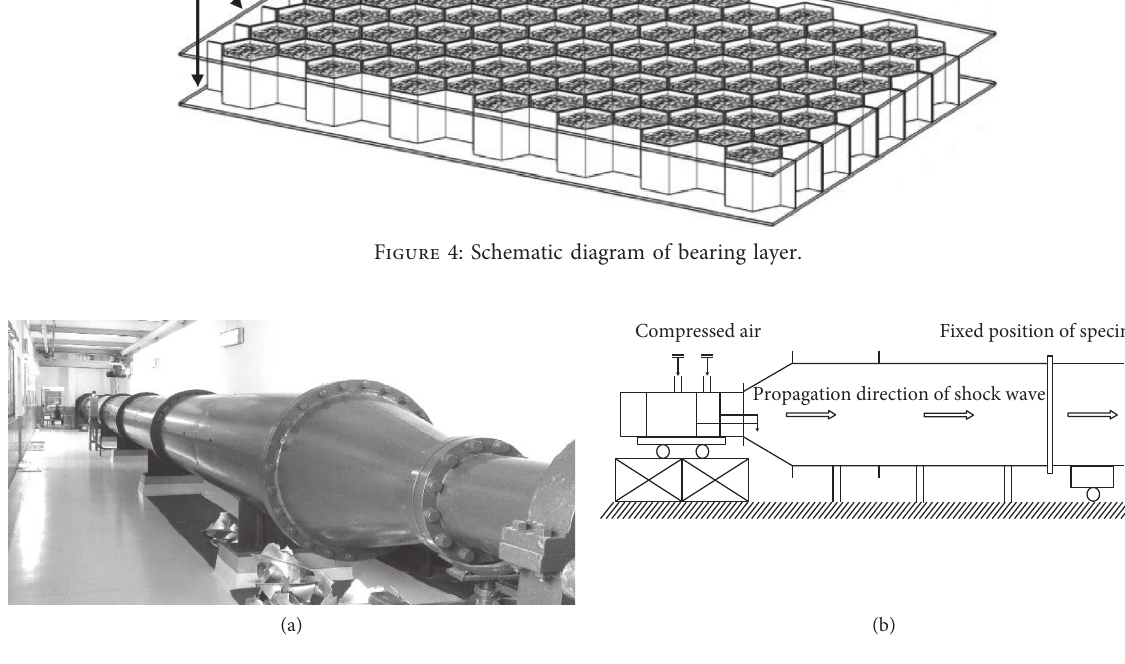
Figure 5: Shock tube device. (a) Real shot. (b) Schematic